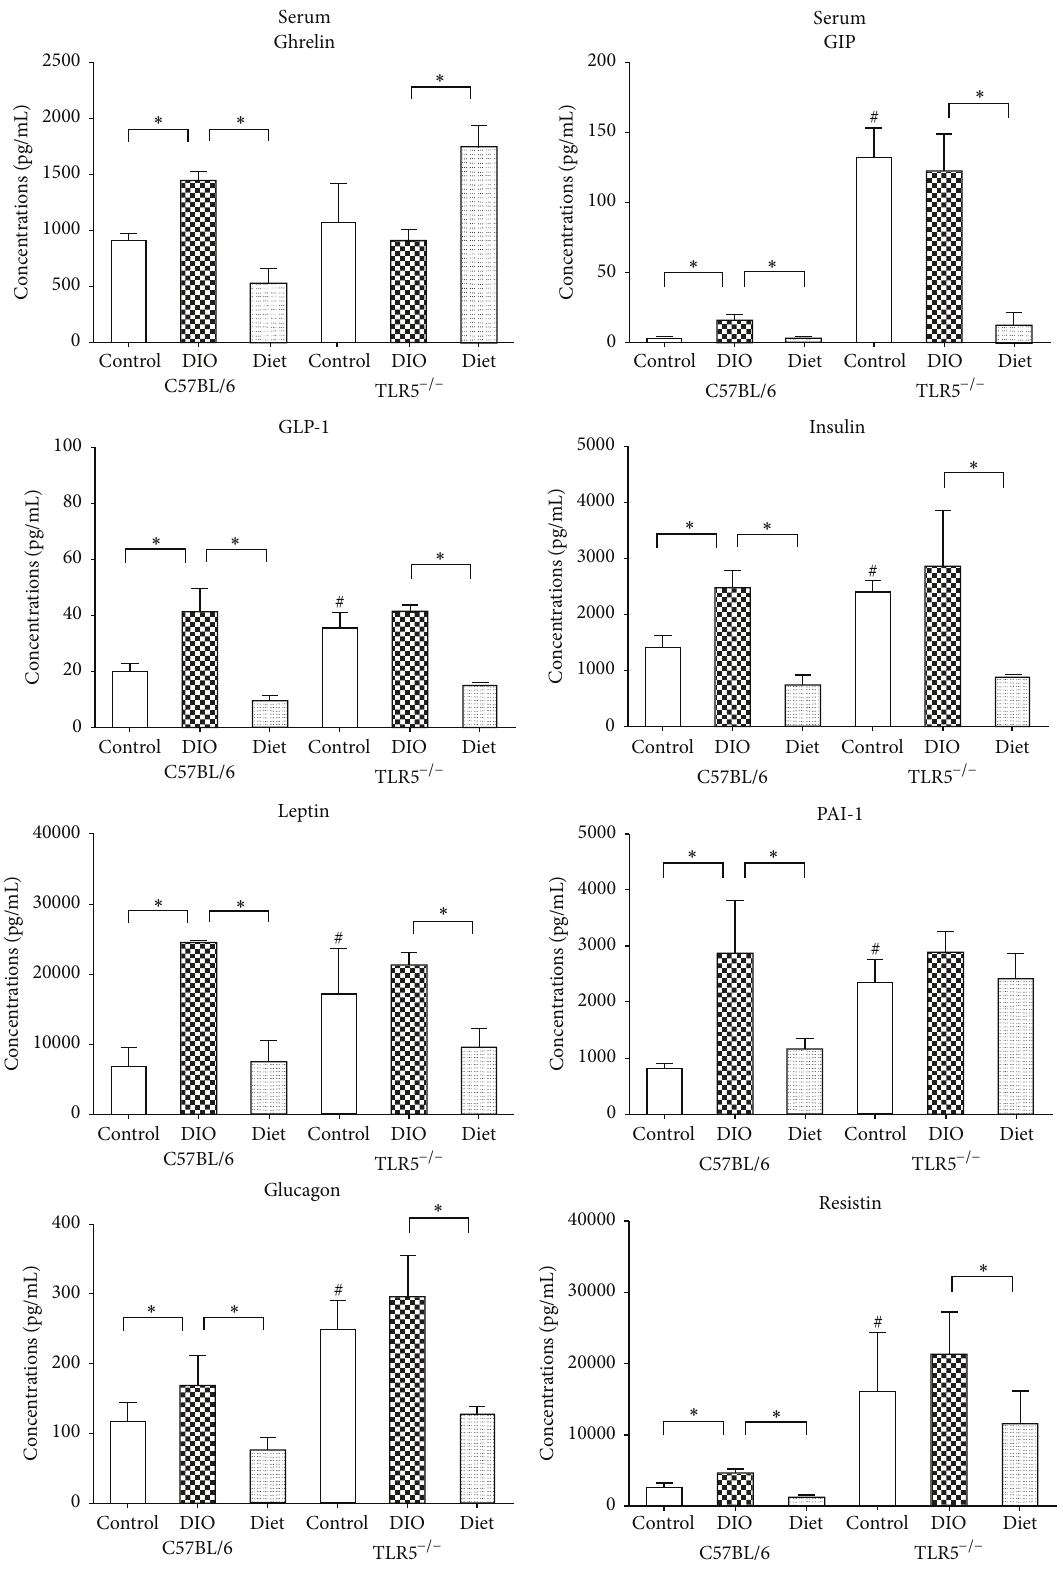
Figure 5: Concentrations of serum cytokines including ghrelin, gastric inhibitory polypeptide (GIP), glucagon-like peptide-1 (GLP-1), insulin, leptin, plasminogen activator inhibitor type 1 (PAI-1), glucagon, and resistin analyzed by the Bio-Plex Multiplex cytokine assay at week 12 in the C57BL/6 and TLR5 −/− mice in groups of control, DIO, and diet. ∗ 𝑝 < 0.05 versus indicated group. # 𝑝 < 0.05 versus control C57BL/6